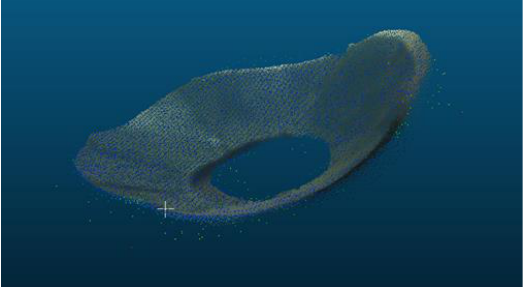
Figure 12. 3 D laser scan before refraction correction for Trial 2 [35,36] (used with permission). Figure 12. 3D laser scan before refraction correction for Trial 2 [35,36] (used with